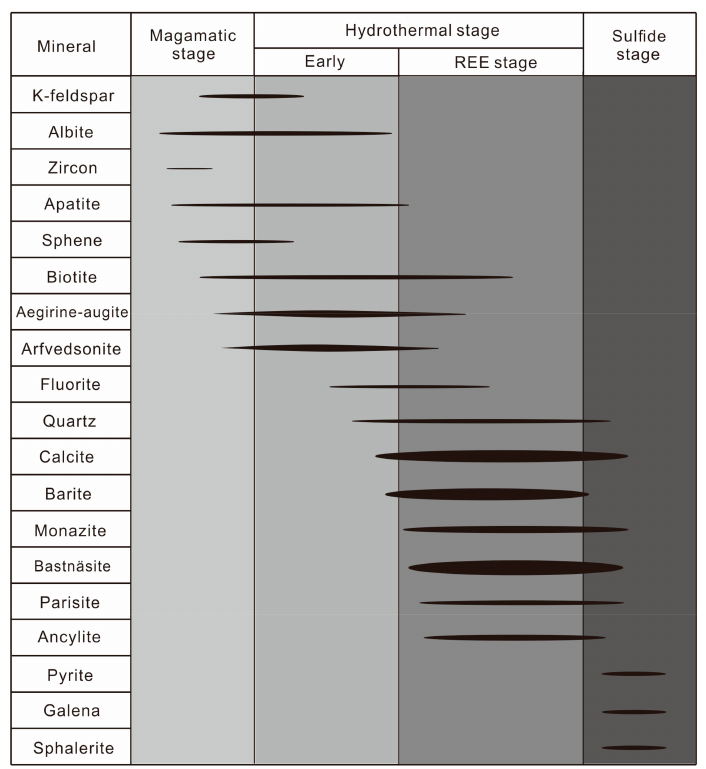
Figure 6. Paragenetic sequence of ore and gangue minerals in the Weishan REE deposit (after